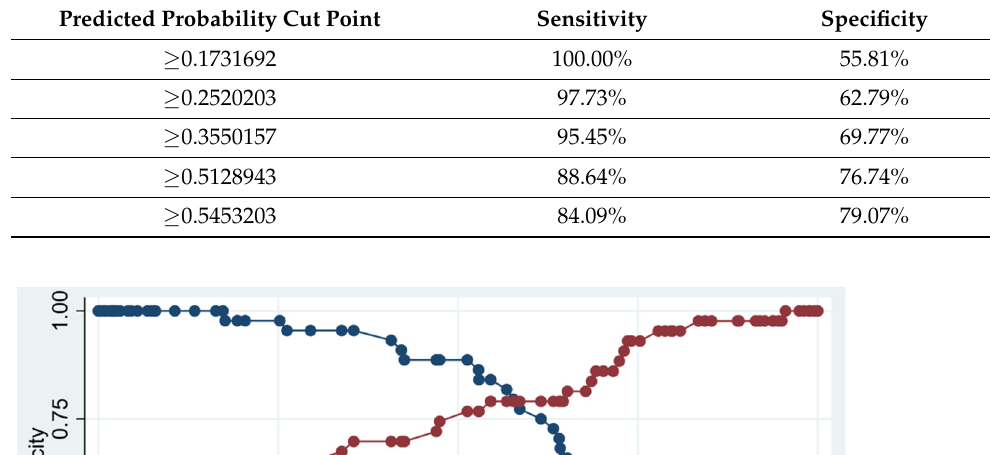
Table 8. Oncology panel: sensitivity/specificity plot for the resulting multivariate logistic regression model, and for sensitivity levels higher than specificity levels.